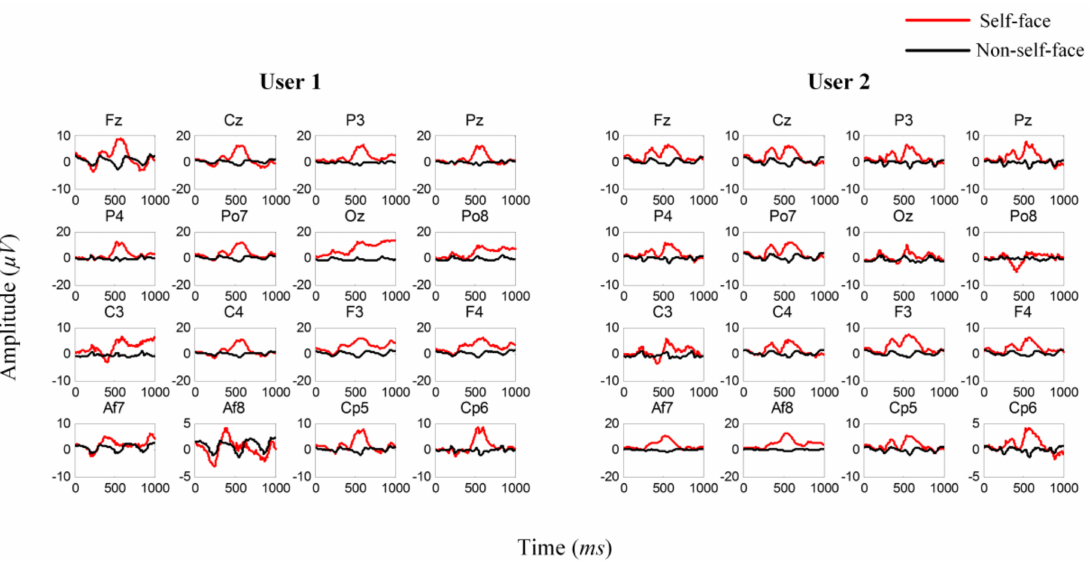
Figure 7. Averaged ERPs of self-face and non-self-face stimuli in two different